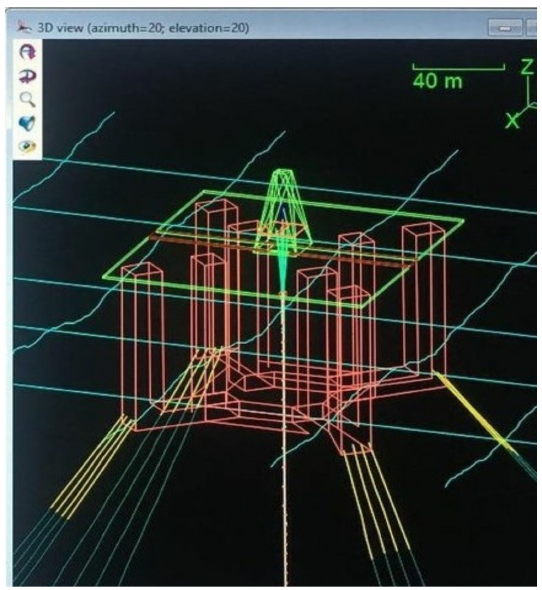
Figure 8. Model for hydrodynamic analysis of a floating semisubmersible platform showing its mooring lines, top deck, derrick and marine risers conducted in OrcaFlex software. Table 6. List of some ocean engineering and hydrodynamic analysis software programs with devel- oper